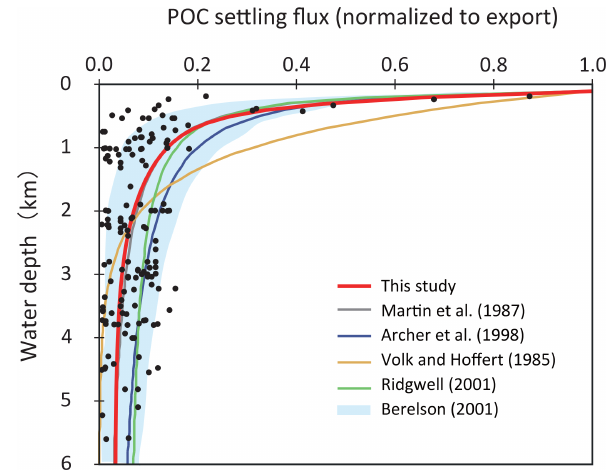
Figure 5. Empirical relationships between POC settling flux nor- malized to export production (Lutz et al., 2002) and water depth (Archer et al., 1998; Berelson, 2001b; Martin et al., 1987; Volk and Hoffert, 1985). The profile of the CANOPS-GRB model is depicted as a red line. The black dots represent observational data (Honjo and Manganini, 1993; Lutz et al., 2002; Tsunogai and Noriki, 1991; Honjo, 1980, and references